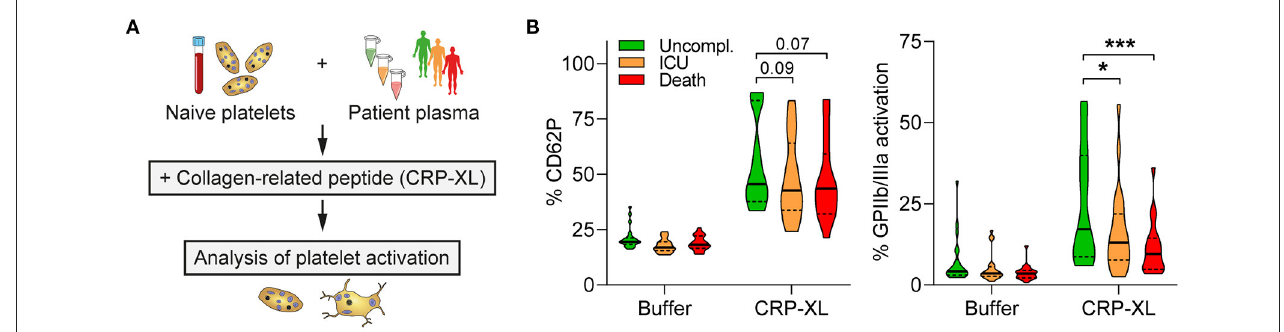
FIGURE 3 | Platelet hypo-reactivity is partially plasma-mediated. (A) Experimental setup: Naïve platelets of healthy donors were incubated with plasma of COVID-19 patients with different outcome (10min), followed by CRP-XL stimulation (50ng/ml, 15min) and evaluation of platelet activation. (B) Surface CD62P expression and GPIIb/IIIa activation (PAC1 antibody binding) determined via flow cytometry. n = 3 platelet donors/7-8 patient plasma per outcome. * p < 0.05, *** p <